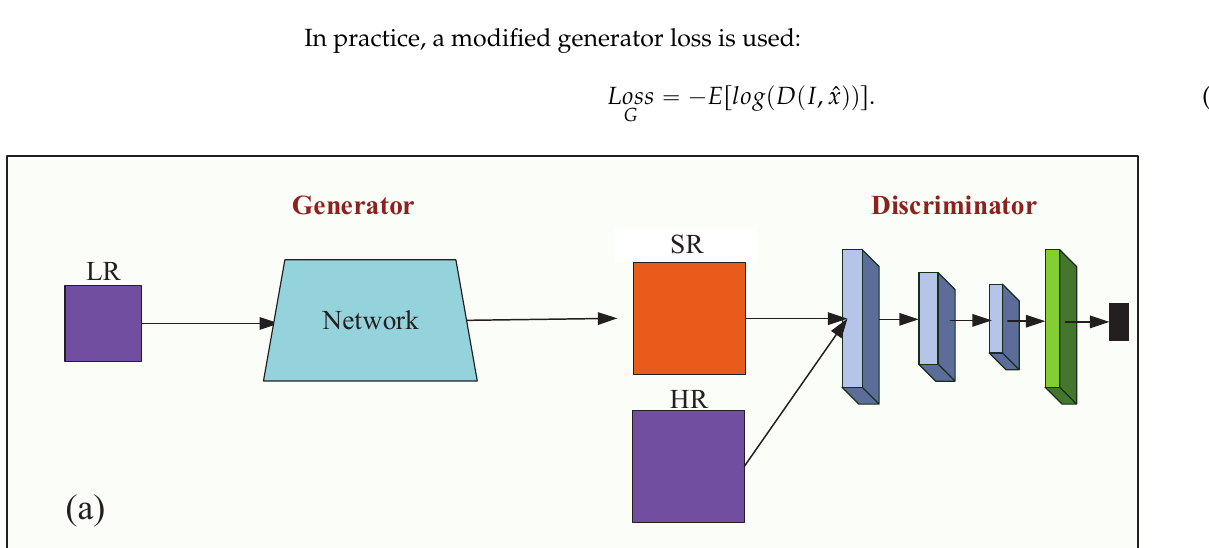
Figure 1. Structure of standard